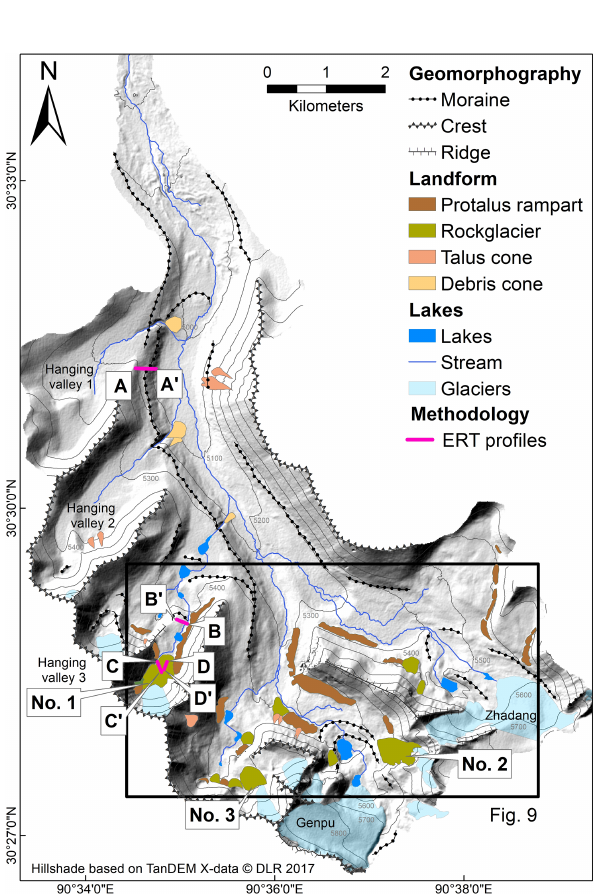
Figure 6. Geomorphological map of the Qugaqie basin. The loca- tions of the ERT profiles are shown with purple lines. Periglacial landforms are greenish (rock glaciers and protalus ramparts). The black rectangle represents the boundary of the map shown in Fig.